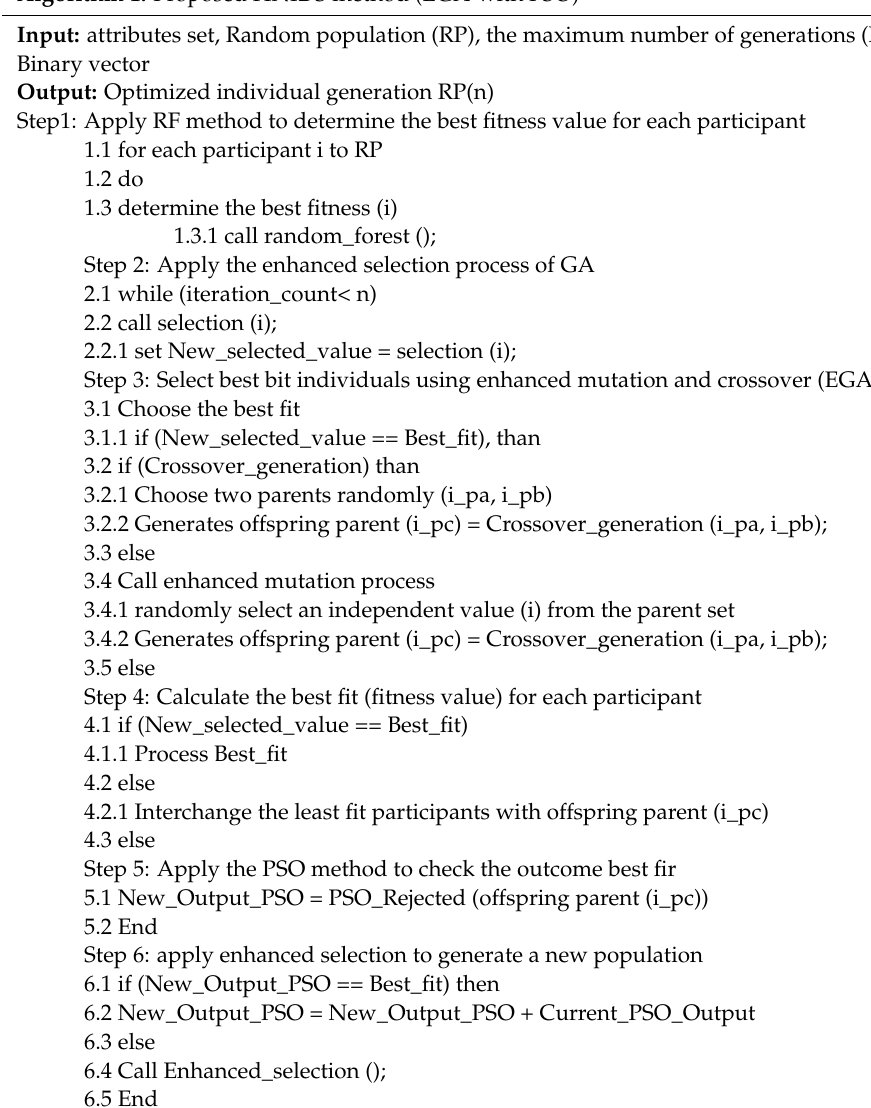
Algorithm 1. Proposed HNIDS method (EGA-with